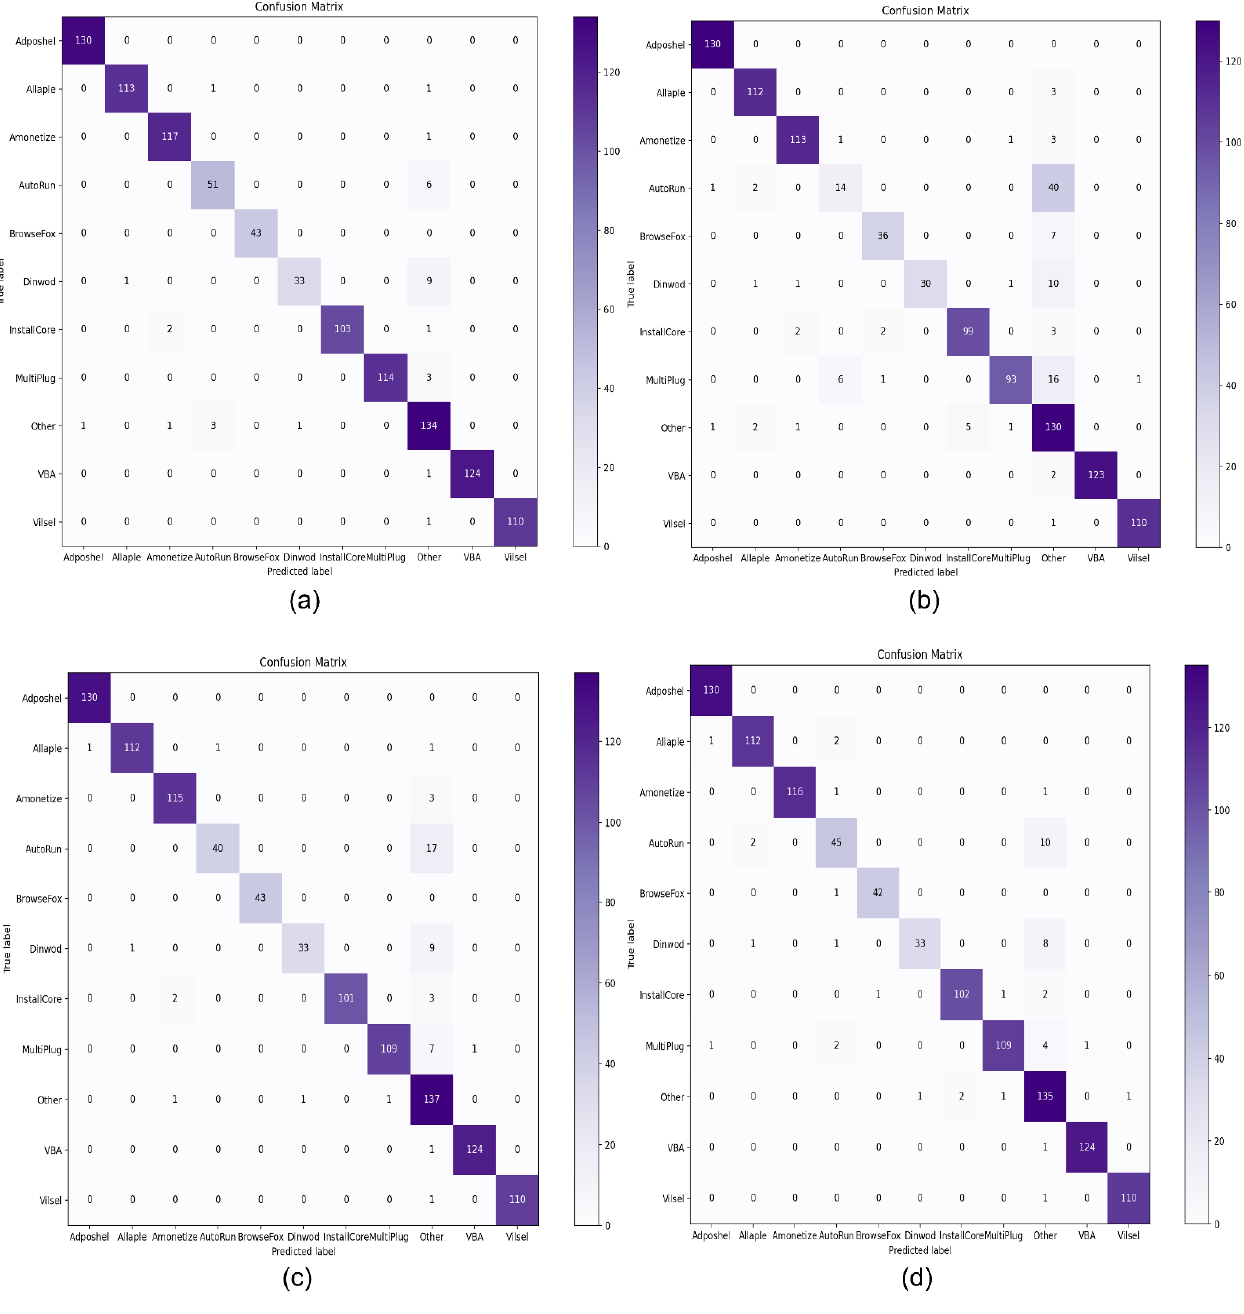
Figure 14. Confusion matrix of SVM-RBF ( a ), SVM-Linear ( b ), RF ( c ), and XGBoost ( d ) using version 2 of the dataset.